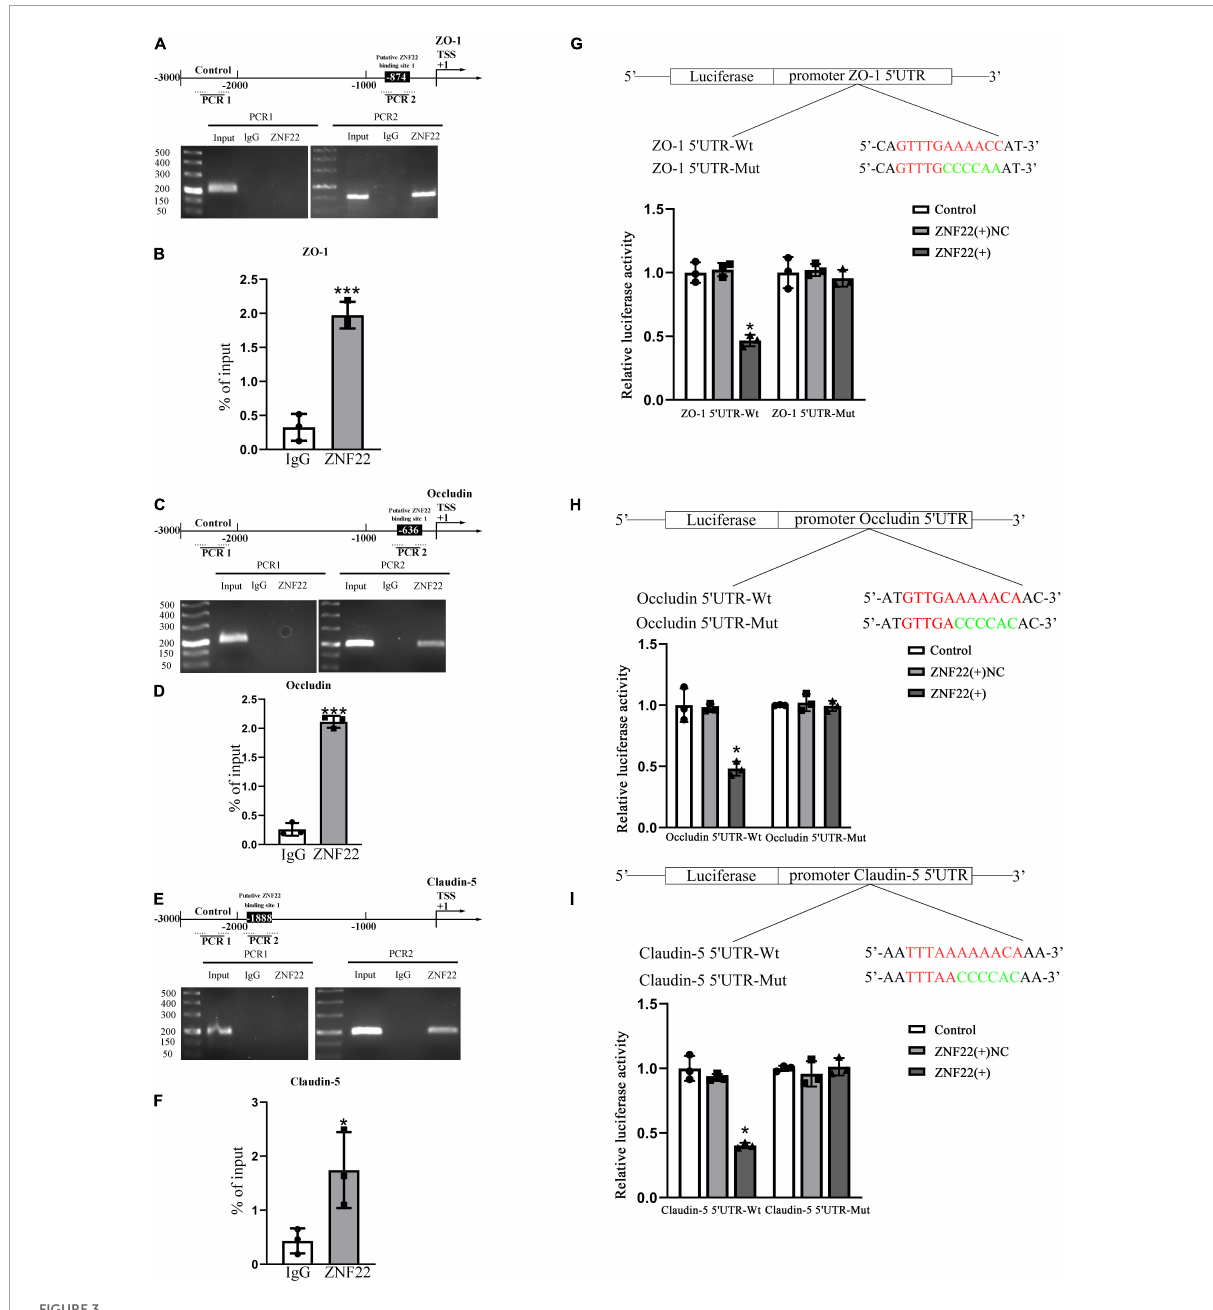
FIGURE3 In the GECs of the BTB, ZNF22 binds to the promoters of TJ-associated proteins. (A) The human ZO-1 promoter regions are shown schematically at 3,000 bp upstream of the transcription start site (marked as TSS, + 1). Using their unique primers, ChIP PCR results for binding sites and upstream areas not anticipated to connect with ZNF22 were amplified by PCR. The Images served as examples of separate ChIP studies. (B) Results of three independent ChIP-qPCRs to confirm the presence of ZNF22 binding to specific regions of the promoter of ZO-1. *** p < 0.001 vs. IgG group. (C) The human Occludin promoter regions are shown schematically in 3,000 bp increments upstream of the transcription start site (TSS, denoted as + 1). Using specified primers, ChIP PCR results for binding locations and upstream areas not anticipated to connect with ZNF22 were amplified. The images were taken from independent ChIP tests. (D) Results of three independent ChIP-qPCRs to confirm the presence of ZNF22 binding to specific regions of the promoter of Occludin. *** p < 0.001 vs. IgG group. (E) The human Claudin-5 promoter regions are shown schematically in 3,000 bp increments upstream of the transcription start site (TSS, denoted as + 1). Using specified primers, ChIP PCR results for binding locations and upstream areas not anticipated to connect with ZNF22 were amplified. The images were taken from independent ChIP tests. (F) Results of three independent ChIP-qPCRs to confirm the presence of ZNF22 binding to specific regions of the promoter of Claudin-5. * p < 0.05 vs. IgG group. (G) ZNF22 and ZO-1 binding sites in GECs were identified using dual luciferase reporter assays. Data represent mean ± SD (n = 3, each). * p < 0.05 vs. ZNF22(+) NC group. (H) The binding sites of ZNF22 and Occludin in GECs were determined using dual luciferase reporter assays. Data represent mean ± SD ( n = 3, each). * p < 0.05 vs. ZNF22(+) NC group. (I) ZNF22 and Claudin-5 binding sites in GECs were determined using dual luciferase reporter assays. Data represent mean ± SD ( n = 3, each). * p < 0.05